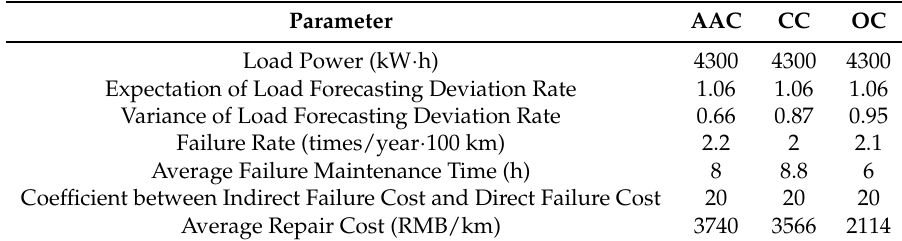
Table 4. Failure parameters in Case 1.